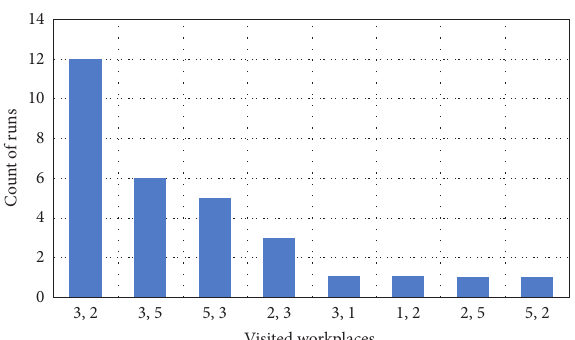
Figure 9: Histogram for the count of runs of the visited workplaces in the optimum solutions.